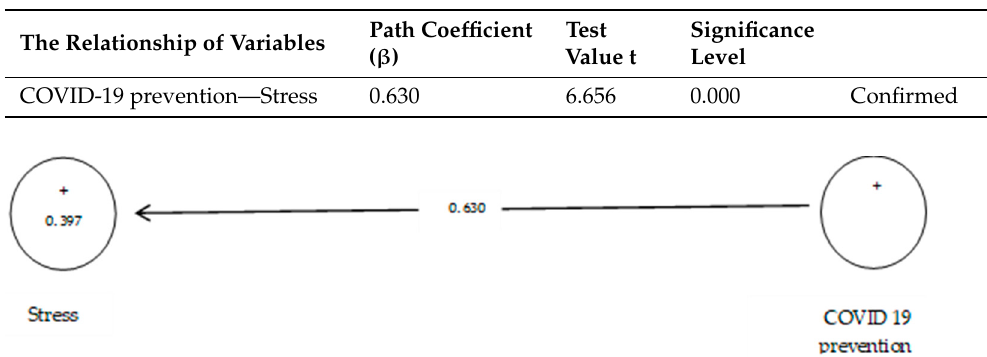
Table 9. Evaluation indicators of the internal model of the research, direction and significance of direct effects.